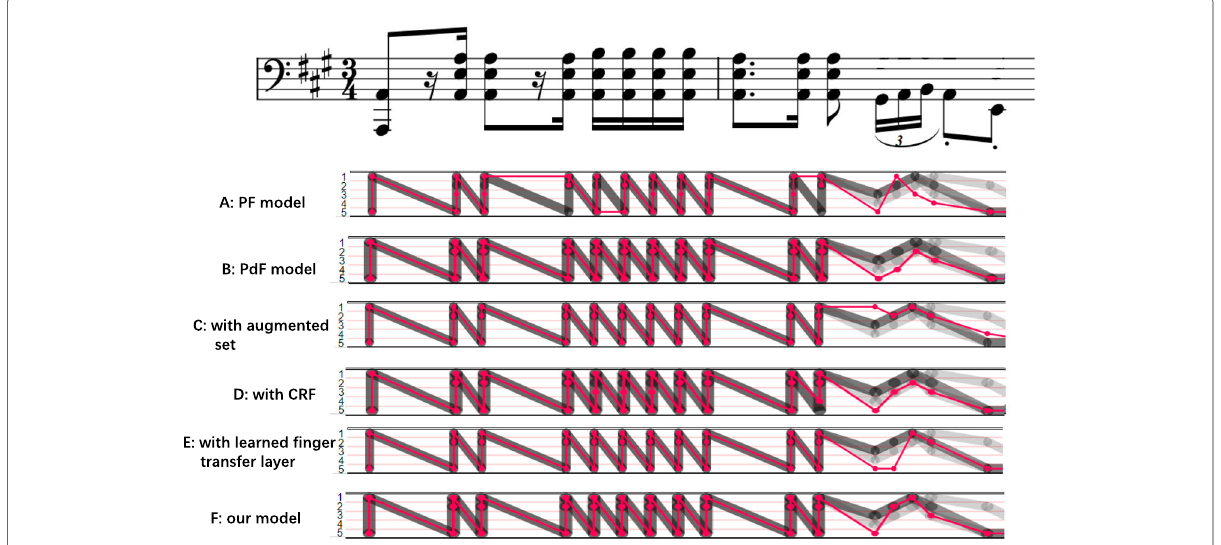
Fig. 9 Comparison of annotation results from a chord of a left-hand fragment in Polonaise Op. 40 No.